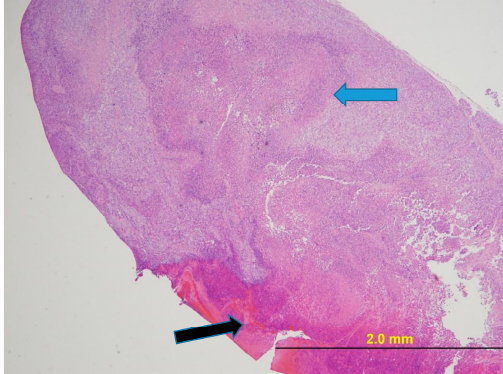
Figure 7. NCI-H460 human NSCLC xenograft (Mouse 3 with ulcerated 1960 mm 3 tumor). H&E stain. The tumor had foci of necrosis consisting of necrotic neoplastic epithelial cells and degenerate and karyorrhectic neutrophils (blue arrow). The surface of the tumor was ulcerated (black arrow). At the margin of the neoplasm, within a band of fibrous connective tissue, neutrophils were admixed with several lymphocytes and plasma cells. several lymphocytes and plasma